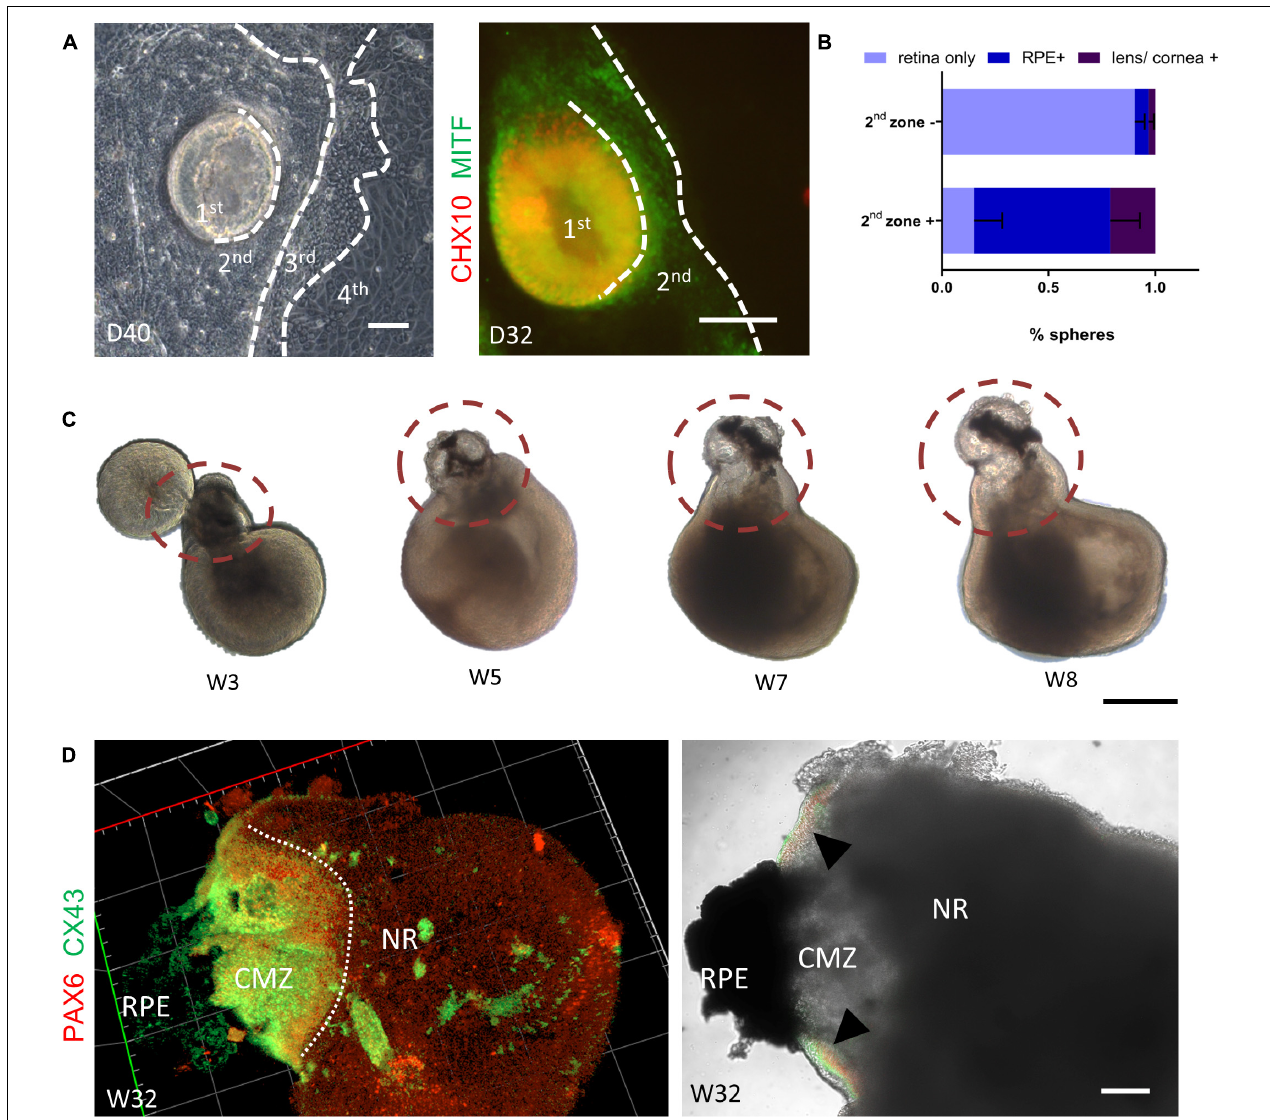
FIGURE 7 | Autonomous generation of the retinal pigment epithelium and the ciliary margin. (A) Representative images showed the autonomous formation of a four concentric-zone cluster. Immunofluorescent staining showed that zone 1 and zone 2 were CHX10- (green) and MITF- (red) positive, respectively. Scale bar = 100 µ m. (B) Compared with isolation without zone 2 [zone 2 (–)], isolation of retinal organoids with zone 2 [zone 2 (+)] generated more RPE spheres ( n = 3 independent experiments per group; each group contained 20 or more retinal organoids). (C) Representative images showing the gradual formation of the peripheral neural retina between the neural retina and the RPE (dashed circle). Scale bar = 500 µ m. (D) Co-staining of the ciliary margin marker PAX6 (green) and CX43 (red) confirmed the generation of ciliary margin zone at Week 32 (triangle). Scale bar = 200 µ